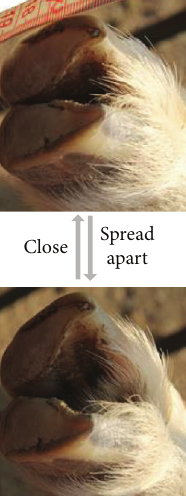
Figure 4: The forefoot of the goat which can close and spread out.